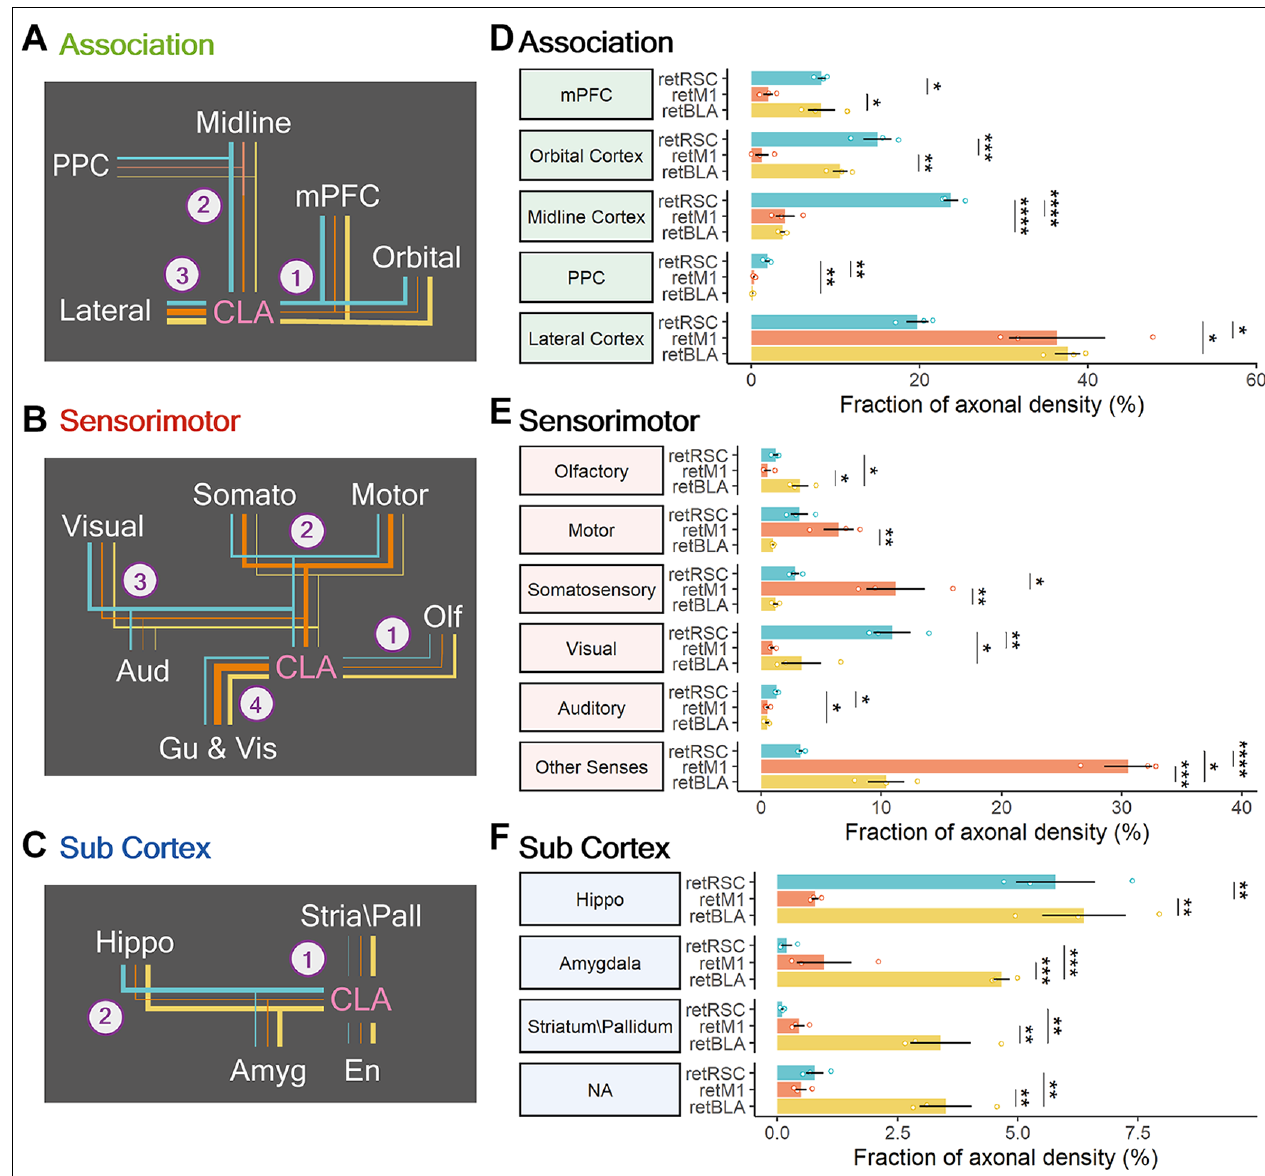
FIGURE 10 | Modularity of CLA neurons projecting to RSC, M1, and BLA. (A–C) Summary of connection strengths and trends in each broad region category. Line colors represent the different CLA projection populations: RSC-projecting (retRSC—teal), M1-projecting CLA neurons (retM1—orange), and BLA-projecting (retBLA—yellow). Line thickness represents strength of innervation by the different CLA neuron populations. Numbered branches represent different innervation trends. e.g., Trend A-1: retRSC and retBLA both project heavily to mPFC and Orbital. Trend A-2: Only retRSC heavily projects to Midline and PPC. (A) For association regions. (B) For sensorimotor regions. (C) For the subcortical category. (D–F) Axonal densities clustered into functional groups to compare innervation preferences across the three CLA projection populations: association cortices (D) , sensorimotor cortices (E) , and subcortical category (F) . Colors represent different CLA populations: retRSC (teal), retM1 (orange), and retBLA (yellow). Statistical testing was based on post-hoc Tukey’s HSD after ANOVA. Significance values: * < 0.05, ** < 0.005, *** < 0.001 and **** < 0.0001.